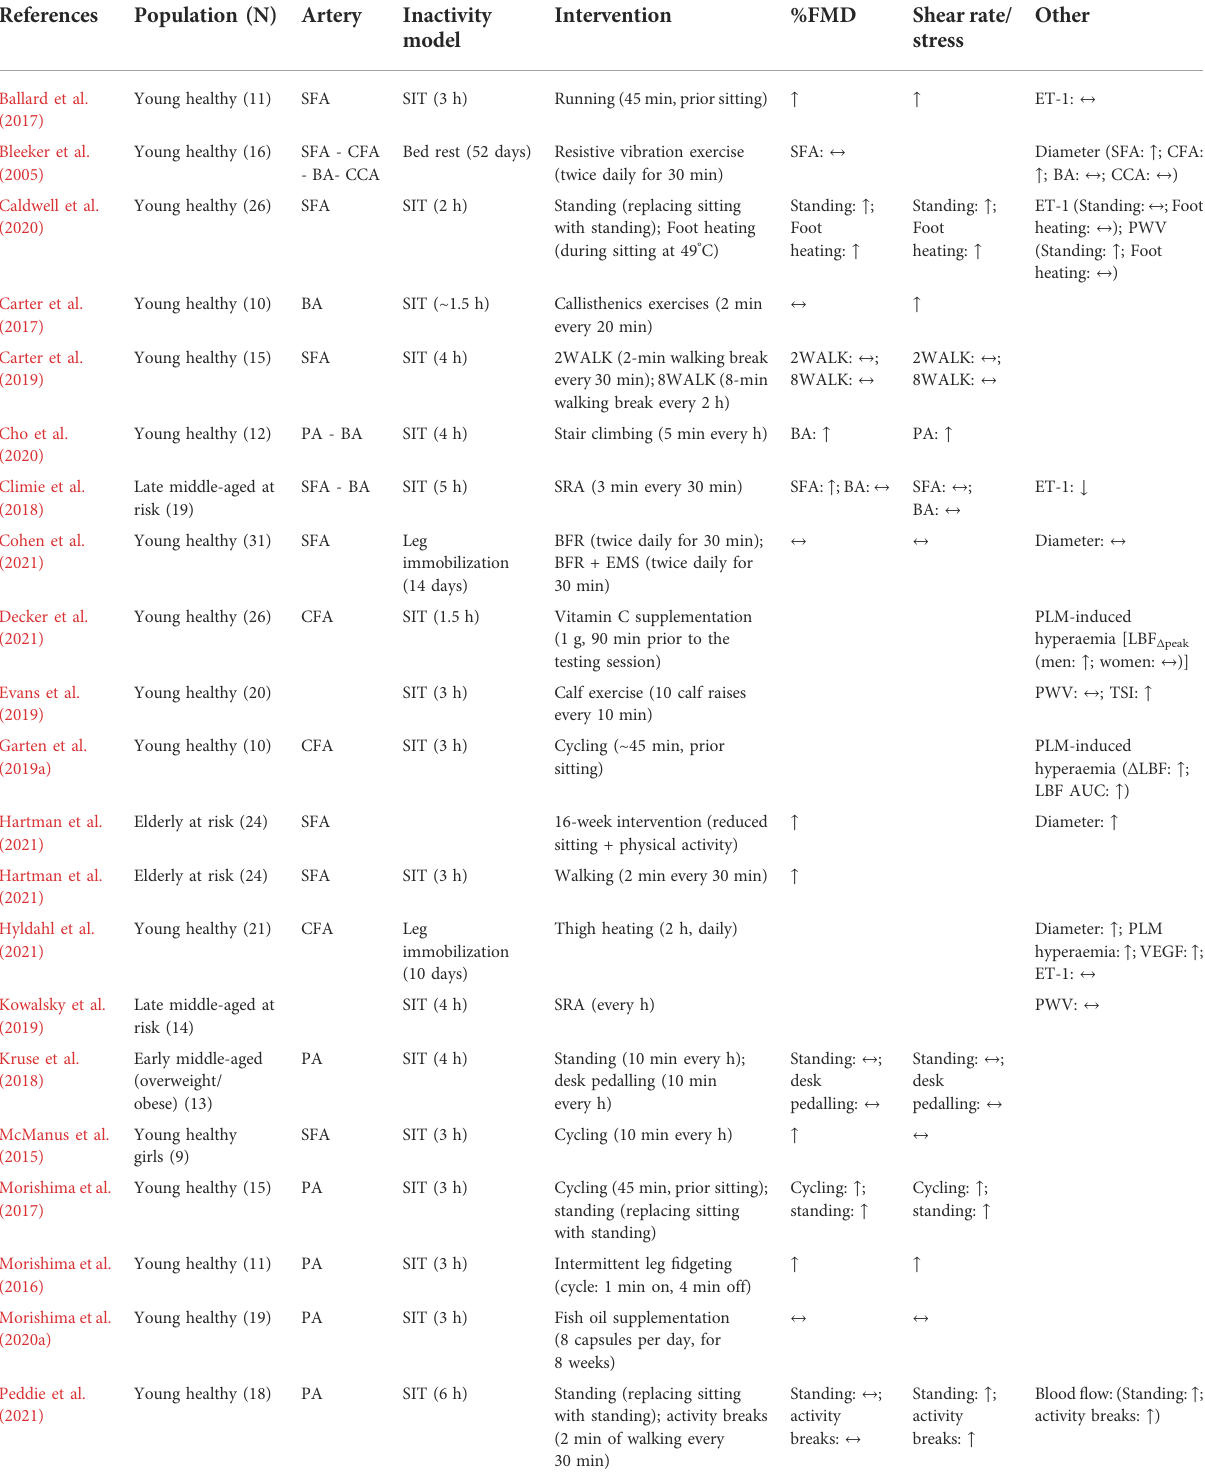
TABLE 3 The effects of counteracting interventions on inactivity-induced vascular dysfunction. Outcome